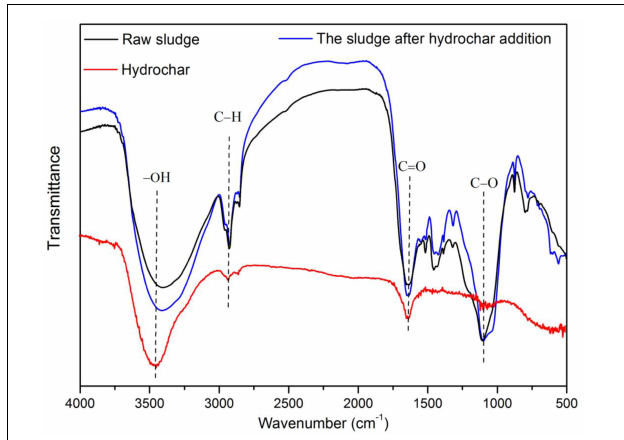
FIGURE 8 | The changes on the functional groups of inoculated sludge after hydrochar addition.